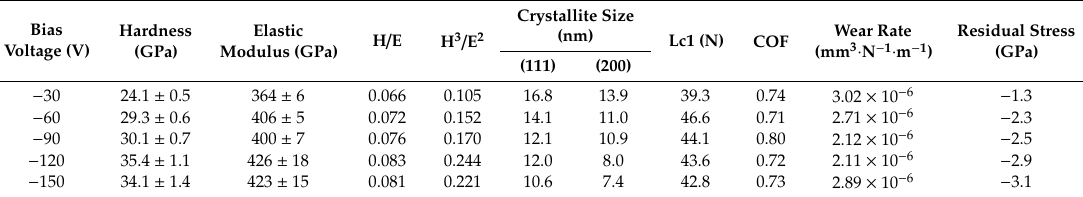
Table 6. Mechanical properties of CrAlN coatings under various bias voltages.